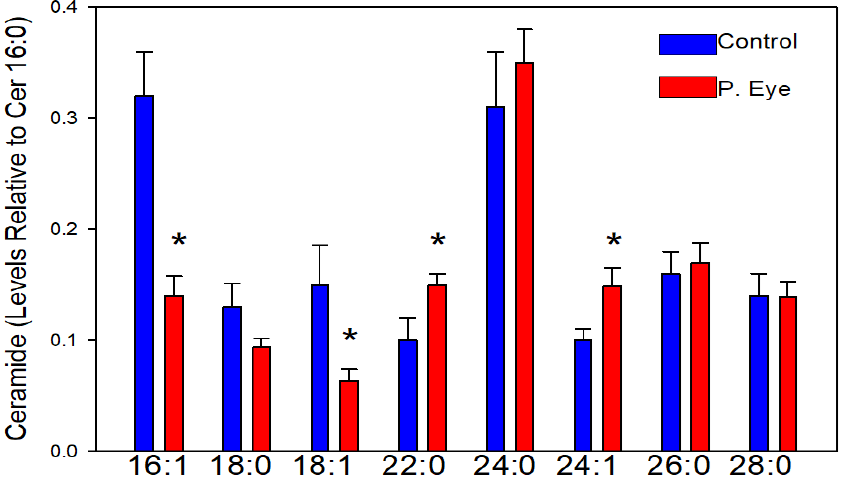
Figure 1. Tear film levels of ceramides (Cer d18:1/x) in controls and cows with pink eye (P. Eye). The peak intensities of individual ceramides are expressed as a ratio of the peak intensity of ceramide d18:1/16:0. *, significant t -test statistics: 16:1 (0.013); 18:1 (0.021); 22:0 (0.027); 24:1 (0.039).